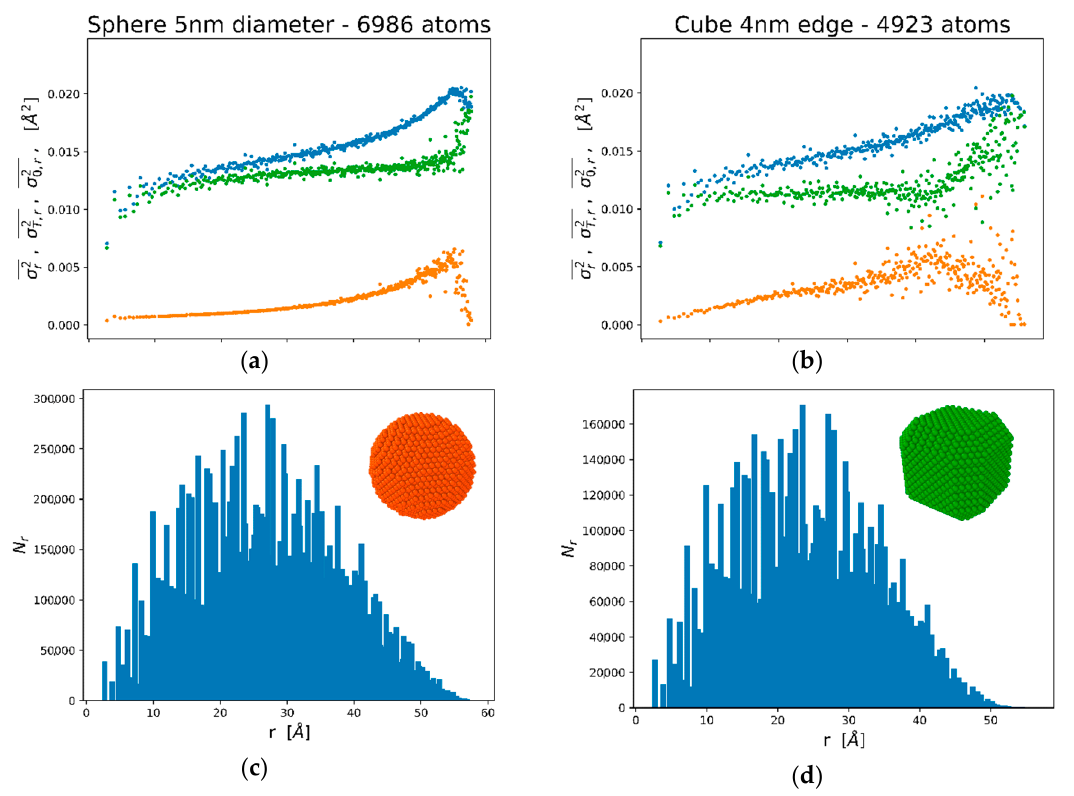
Figure 2. Trends of the Mean Square Relative Displacement (MSRD) for a spherical ( a ) and truncated cube ( b ) crystal, N = 6986 and N = 4923 Pd atoms, respectively; corresponding number of atom pairs ( N r ) is shown by histograms in ( c ) and ( d ). MSRD is shown for the total (blue), static (orange), and thermal (green) components, as of Equation (3), (4), and (5), respectively. Insets in ( c ) and ( d ) show images of the nanoparticle shapes.